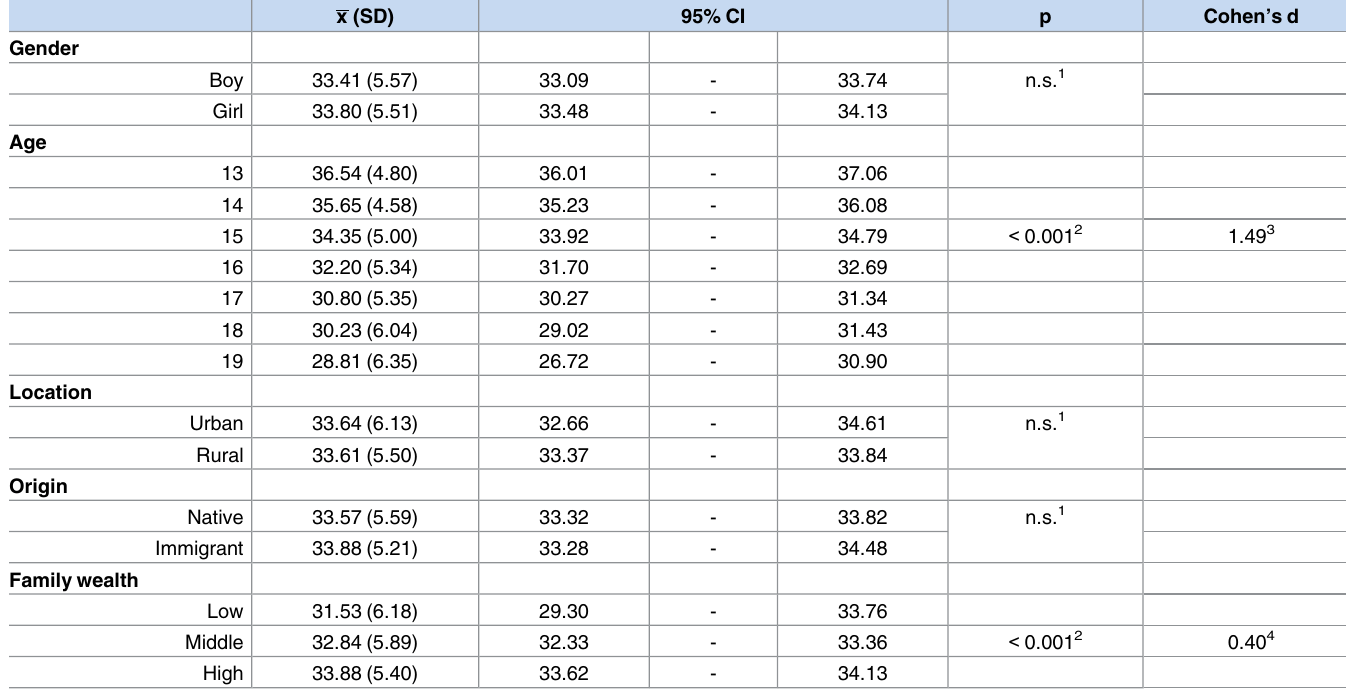
Table 3. Descriptivestatistics of the total score with respect to the different